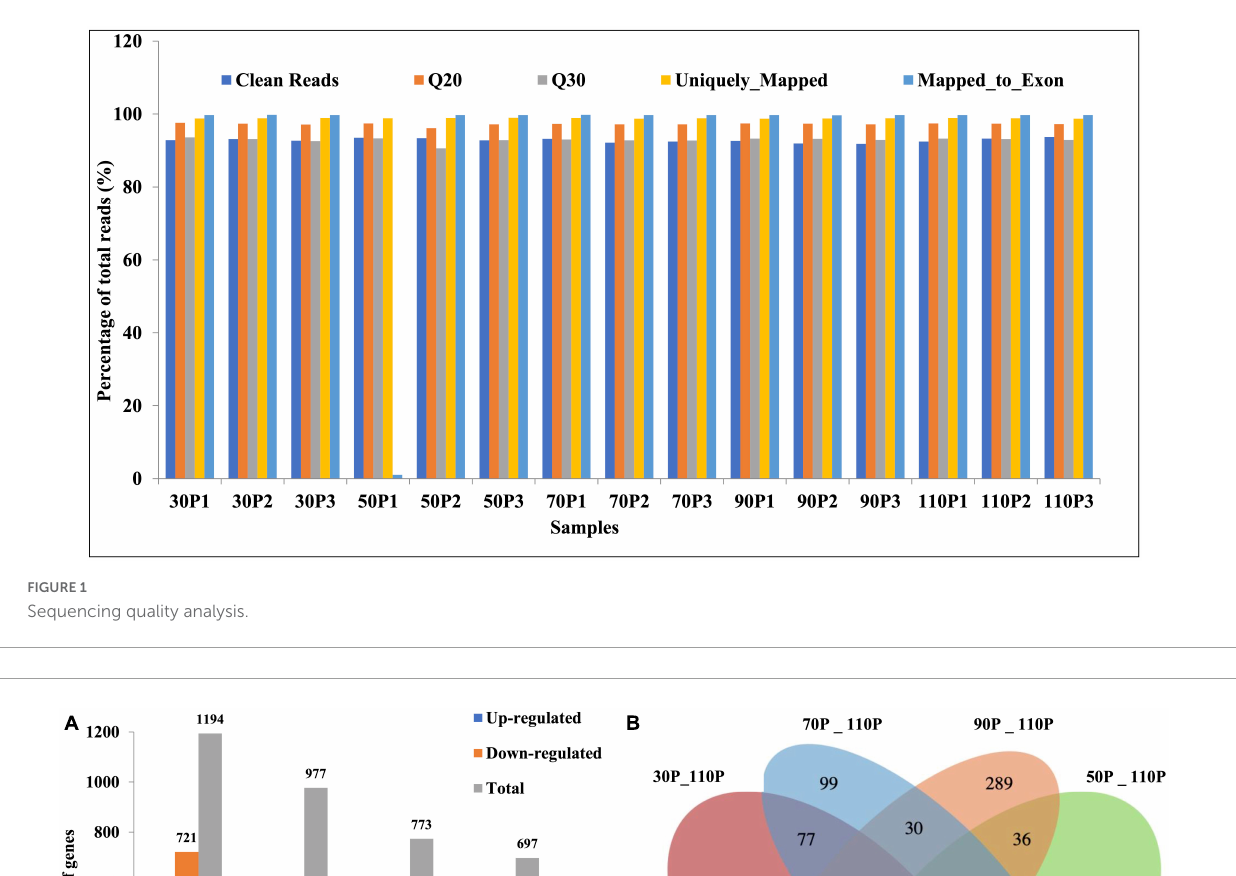
FIGURE1 Sequencing quality analysis.